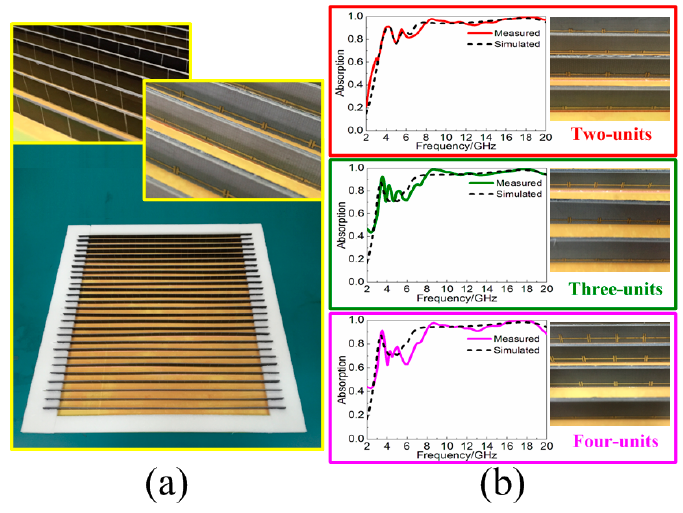
Figure 9. ( a ) Fabricated samples of the combined MAs in Figure 7; and ( b ) measured and simulated absorption spectra for the combination of two-units, three-units, and